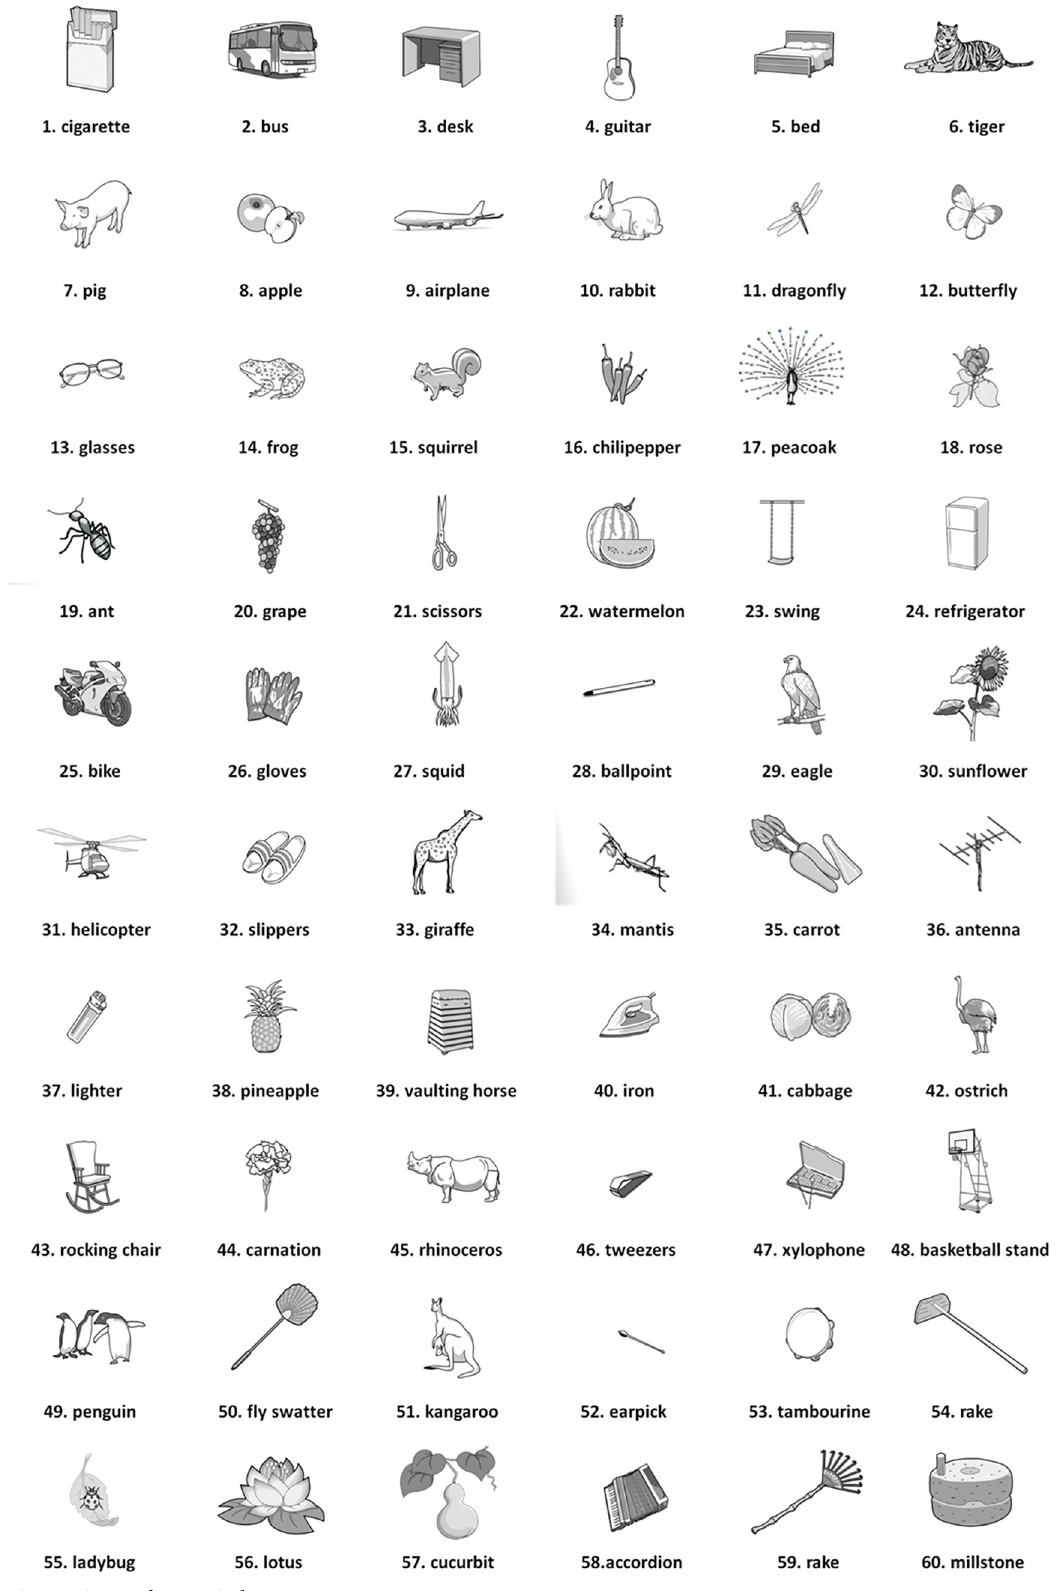
Fig 1. 60 items of categorical naming